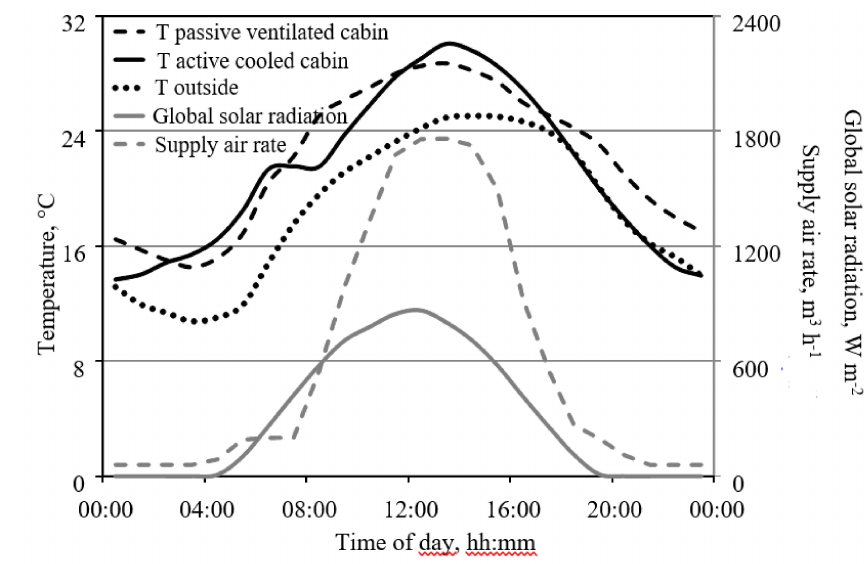
Figure 6. Daily course of temperature in two cabins on 10 May 2016. One cabin was cooled by increasing the supply air rate with increasing cabin temperature, while the other was cooled by blowing cabin air into the cooled troughs. The maximum supply air rate corresponds to an exchange rate of the cabin air of about 16 h − 1 . In both cabins, a fully developed tomato crop was cultivated. Set points for heating at night and day and opening the greenhouse roof windows were 15, 19, and 32 ◦ C,